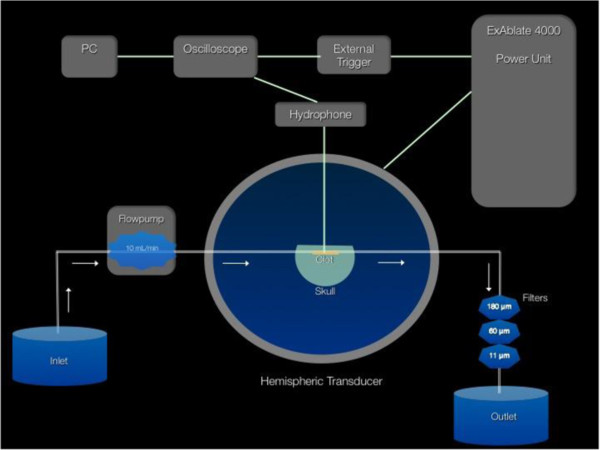
Schematic display of the in vitro HIFU thrombolysis and clot fragmentation experimental setup. The hydrophone position describes the location of the natural focus beam, in the center of the blood clot.